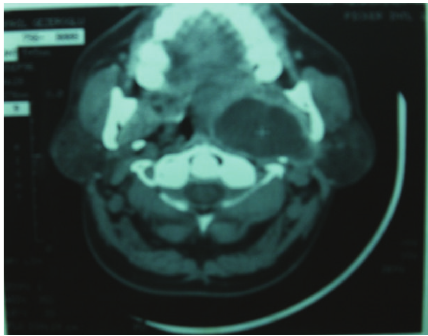
Figure 5: Axial CT